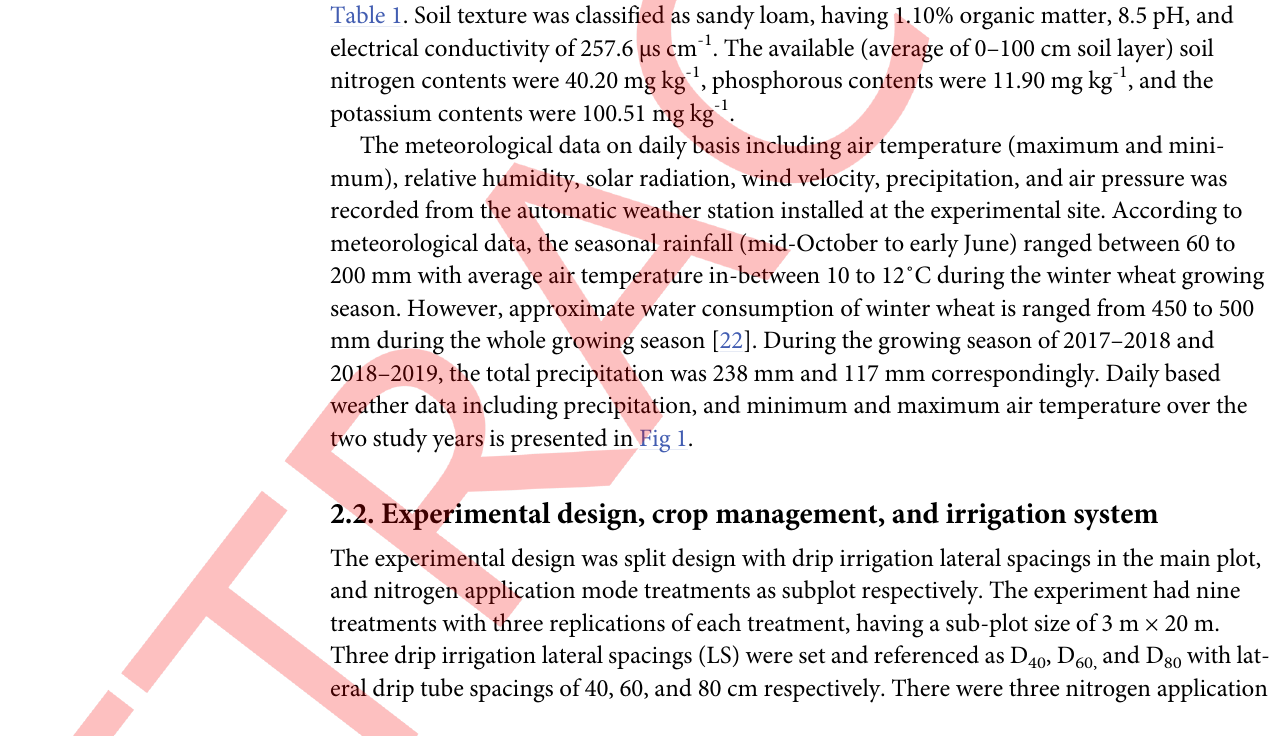
Table 1. Physical and chemical properties of the experimental